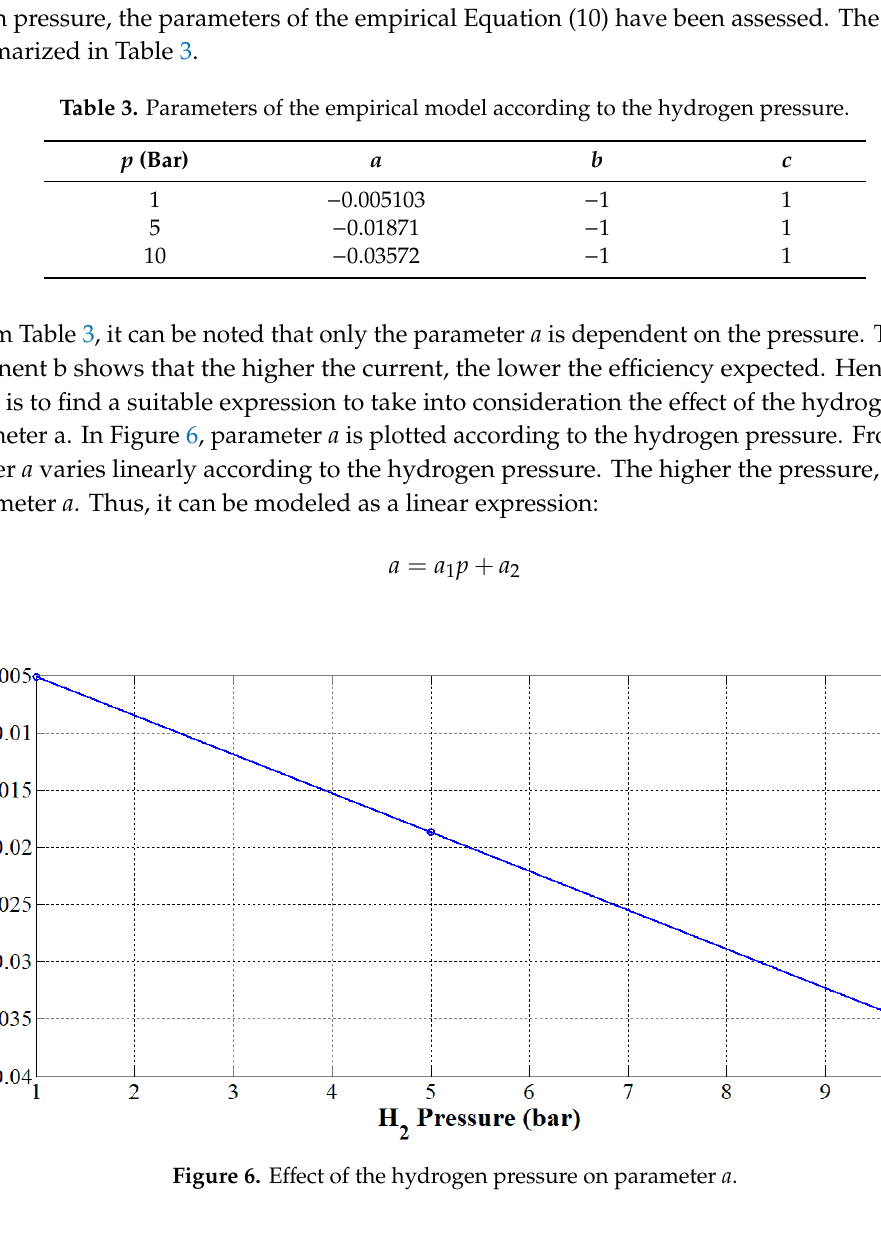
Table 4. Parameters of the linear model.